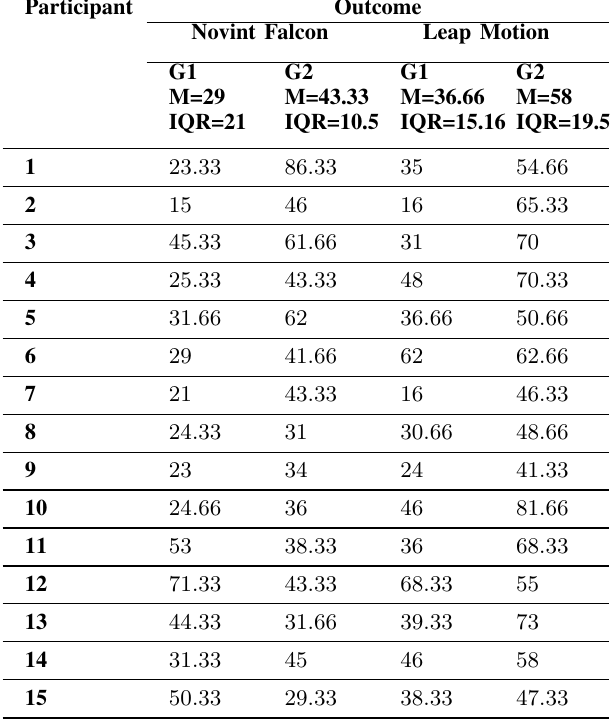
TABLE V E VALUATION RESULTS OF THE EXERCISE IN TERMS OF WORKLOAD ( MENTAL , PHYSICAL AND TEMPORAL DEMAND , EFFORT , FRUSTRATION LEVEL AND PERFORMANCE ). G1: GROUP OF HEALTHY ADULTS , G2: GROUP OF ELDERLY WITH HAND MOTOR IMPAIRMENTS . M:M EDIAN , IQR:I NTER -Q UARTILE R ANGE